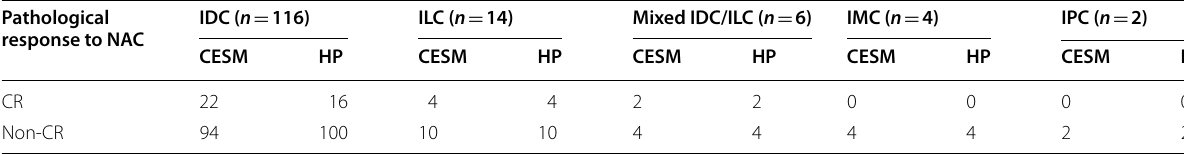
NAC neoadjuvant chemotherapy, IDC, invasive duct carcinoma, ILC invasive lobular carcinoma, IMC invasive medullary carcinoma, IPS invasive papillary carcinoma , n number, CESM contrast-enhanced spectral mammography, HP histopathology, CR complete response